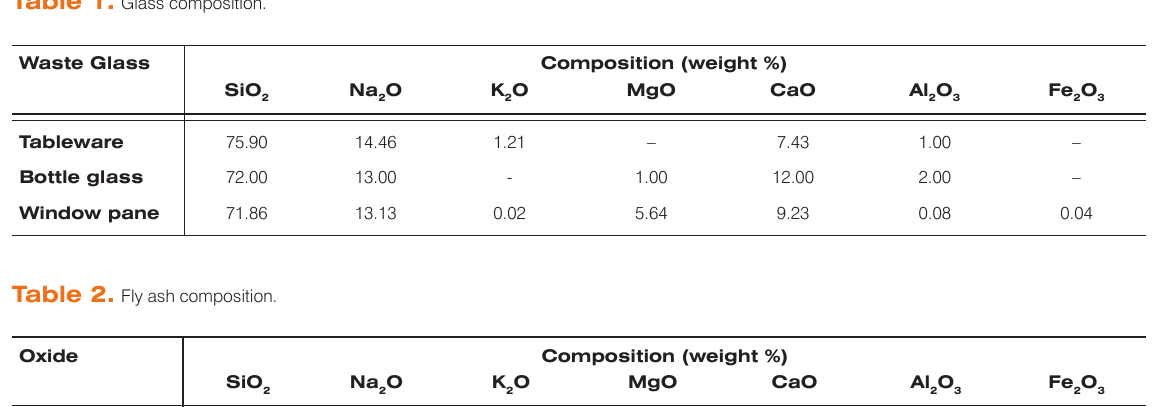
Table 1. Glass composition.